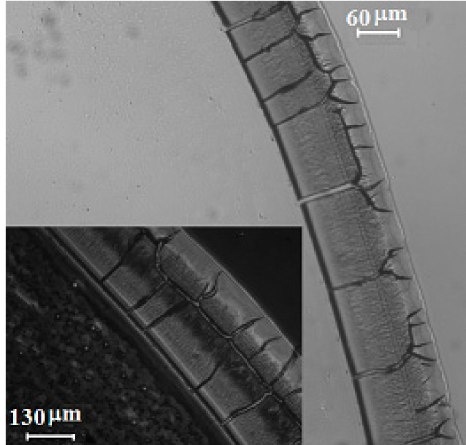
Figure 7. Ring phenomenon caused by evaporation of mixture of water and fluorescent nanoparticles on glass